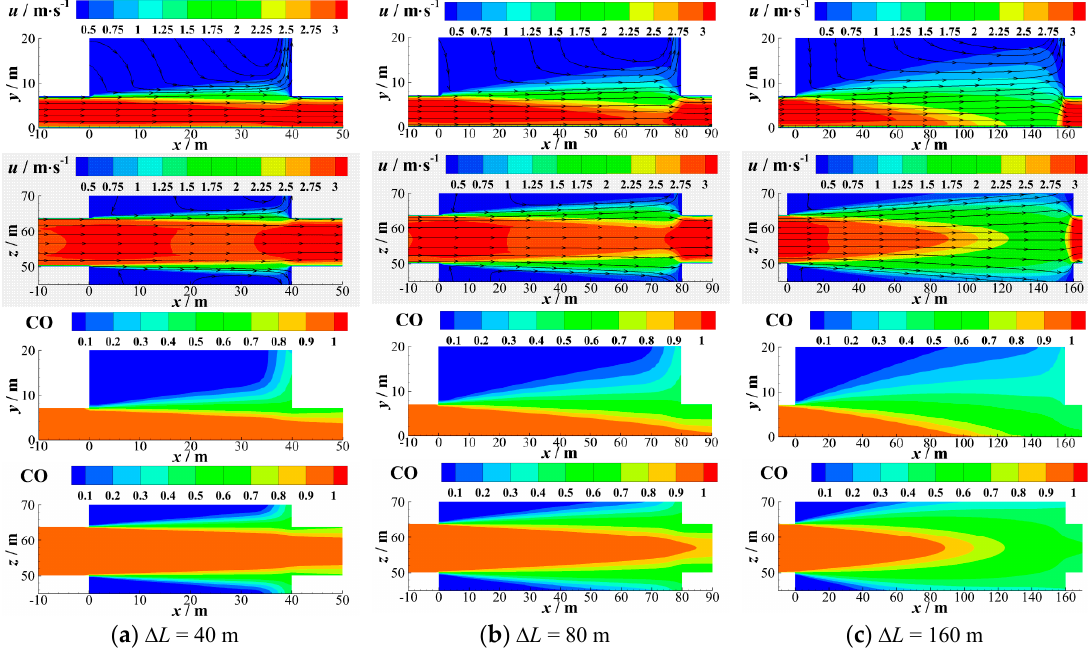
Figure 3. Flow structure and CO concentration distribution between the portals of consecutive tunnels under different ∆ L.